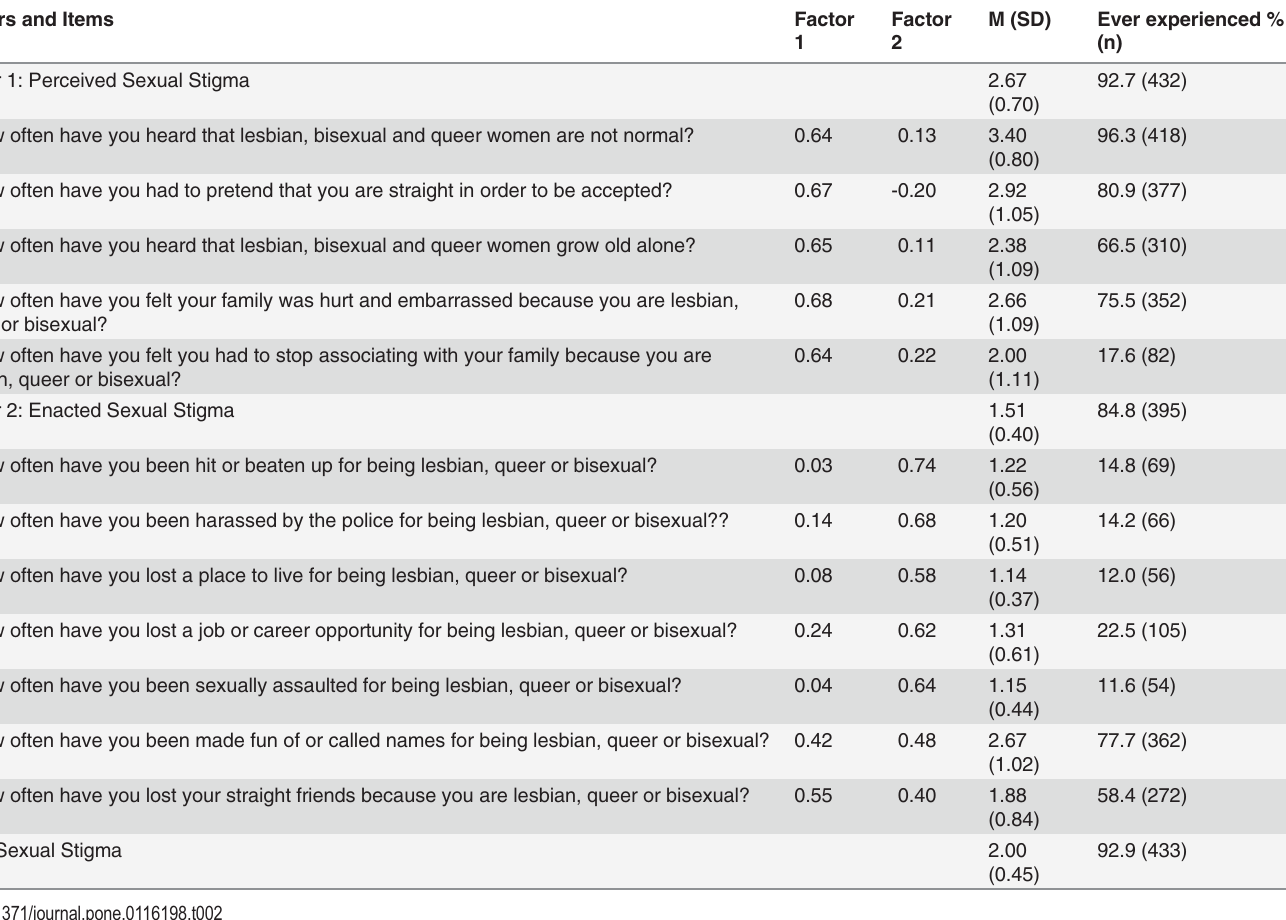
Table 2. Items factor loadings, mean (standard deviations), and proportions for the sexual stigma scale adapted for lesbian, bisexual and queer women (phase 2 sample: n = 466).